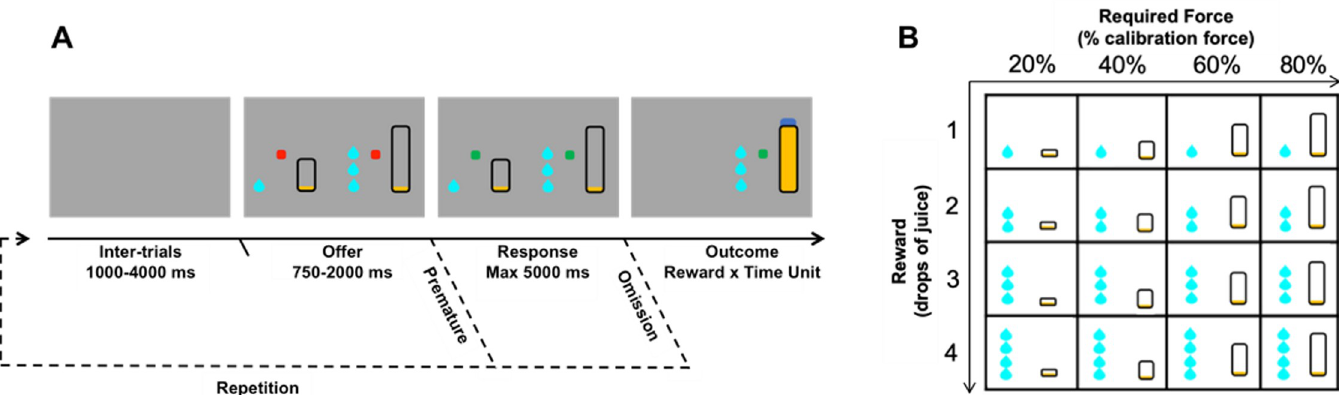
Fig 1. Behavioral task design. A. Schematic description of a trial sequence with successive screenshots displayed to the monkeys. A trial started with a gray screen (intertrial phase) followed by the presentation of 2 red instruction dots and 2 options, each of them composed of a reward cue and a required force cue (offer phase). When the instruction dots turned green (response phase), the monkeys could choose 1 option by pressing the corresponding handgrip (left or right). A continuous visual feedback was displayed to signal the online force exerted by the monkey (yellow filling of the required force cue). The announced reward (drops of juice) was delivered if and when the exerted force reached the target force (outcome phase). The same trial started again if the monkey responded before the end of the offer phase (premature error) or provided no response at all (omission). B. Experimental design for the combinations of required force and reward size used to define options. Each option, regardless of its side of presentation, was defined by a combination of a given reward level (1, 2, 3, or 4 drops) and a given required force (20%, 40%, 60%, or 80% of the calibration force). The effort and reward components of each option were manipulated systematically and randomly, such that the influence of effort and reward on choices were orthogonalized by design. All possible combinations of pairwise options were sampled during the